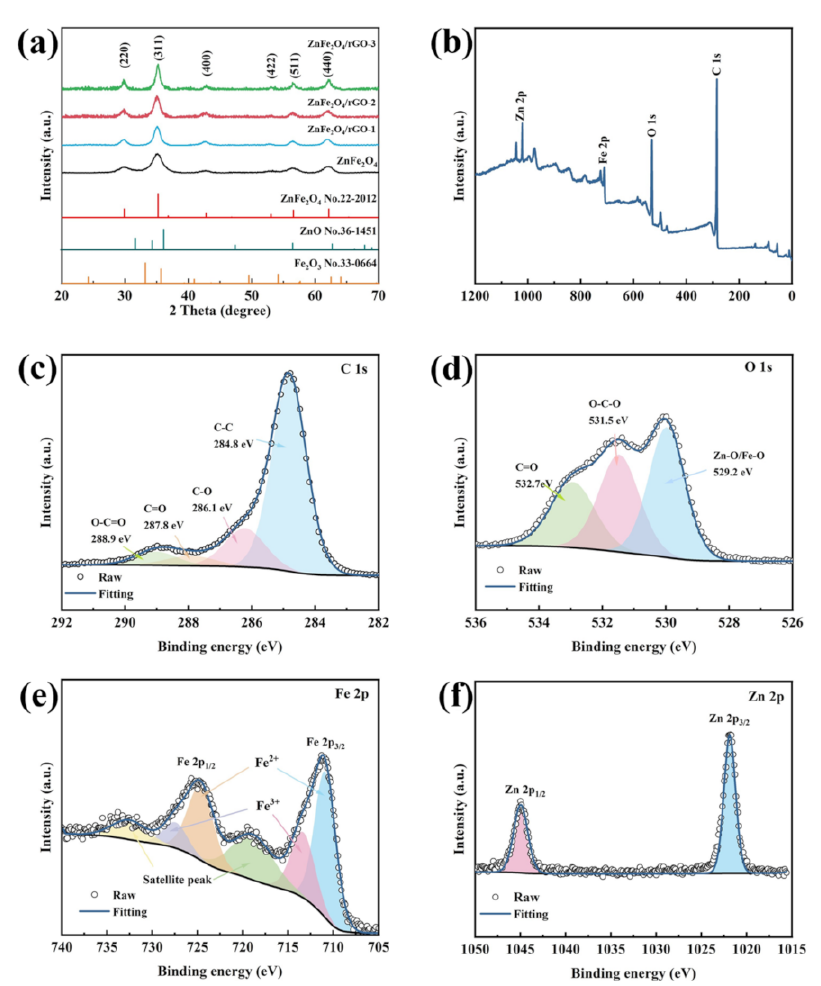
Figure 1. ( a ) XRD profiles of ZnFe 2 O 4 , ZnFe 2 O 4 /rGO–x (x = 1, 2, 3). Full XPS survey spectrum ( b ), High-resolution XPS spectrum of ( c ) C 1s, ( d ) O 1s, ( e ) Fe 2p, and ( f ) Zn 2p of ZnFe 2 O 4 /rGO −